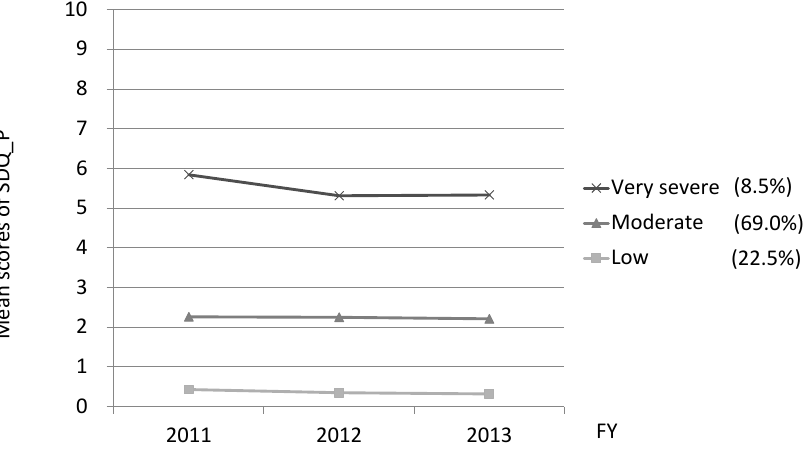
Figure 2. Trajectories of the three-group model of peer relationship problems. The mean scores of peer relationship problems of the three-group (very severe, moderate, low), using semi-parametric group-based modelling.